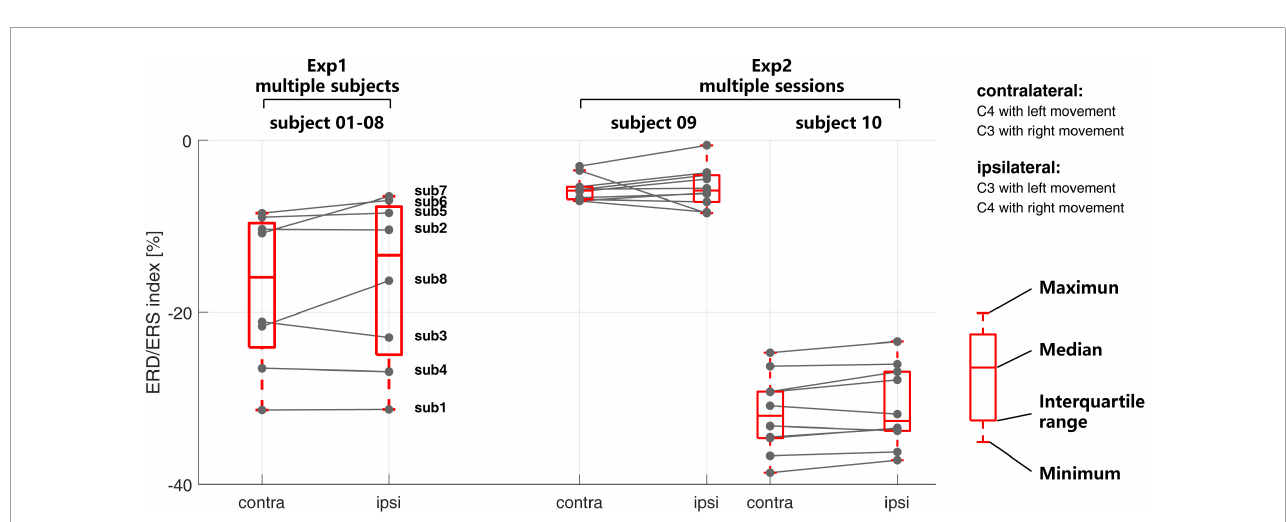
FIGURE5 The inter- and intra-subject variability of the event-related desynchronization/synchronization (ERD/ERS) index in Exp1 and Exp2.